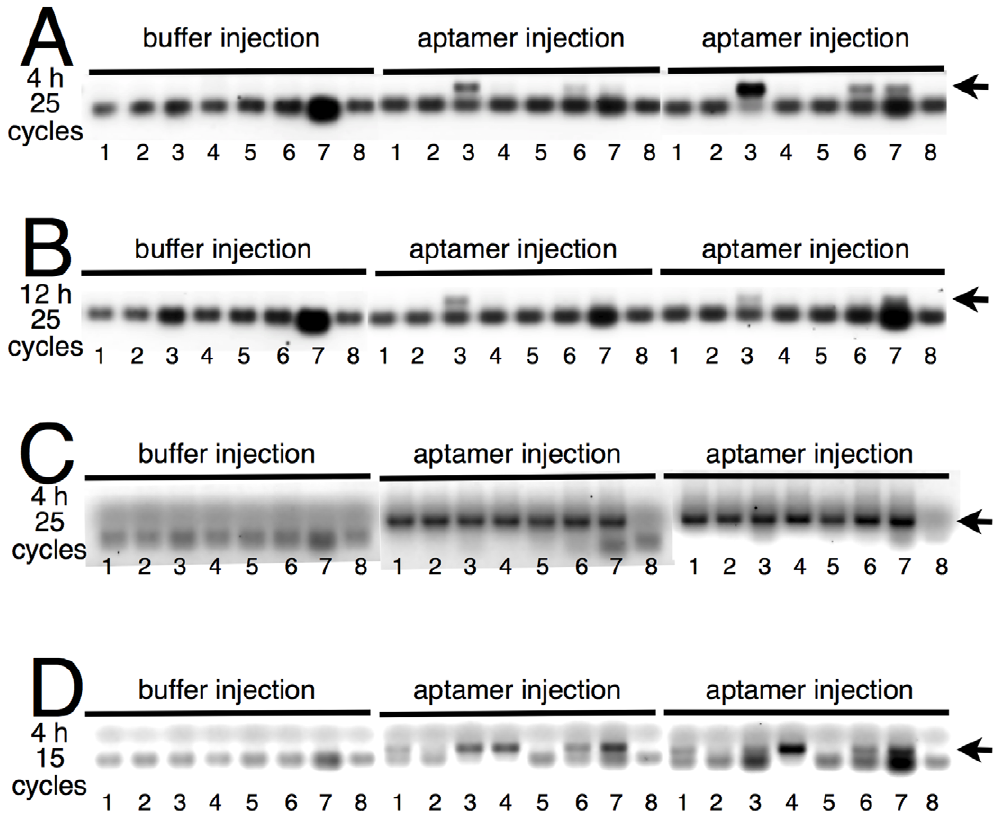
Figure 4. Tissue distribution of DNA aptamer 3064 conjugated to biotin 4 h (A, C, D) or 12 h (B) after i.p. injection into healthy FVB mice (A, B) or TMEV-infected SJL/J mice (C, D). Control animals (‘‘buffer injection’’ group in each panel) were injected with the equivalent buffer solution lacking aptamer conjugate. Conjugates were extracted from duplicate mice (middle and right group in each panel) and detected by the indicated number of PCR cycles as described in Methods. Each lane reflects PCR products amplified from extract representing 8.25 mg original tissue wet weight. Arrows indicate position of 120-bp aptamer-specific PCR product. Numbering: 1, heart; 2, spinal cord; 3, spleen; 4, lung; 5, brain; 6, kidney; 7, liver; 8, water control. A nonspecific prominent PCR product (higher mobility than the aptamer-specific product) results from primer-primer interactions.